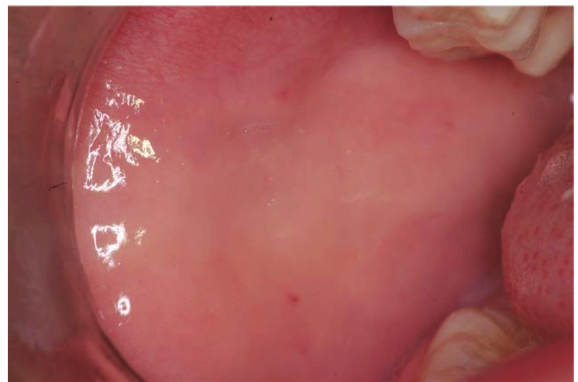
Figure 6: The clinical aspect of health mucosa at 30-day follow-up